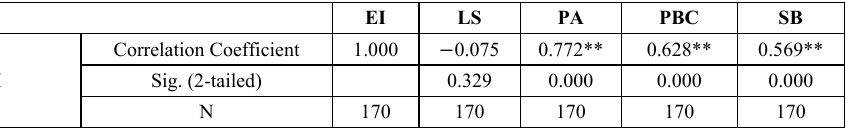
Table 2. Correlations: Spearman’s rho EI LS PA PBC